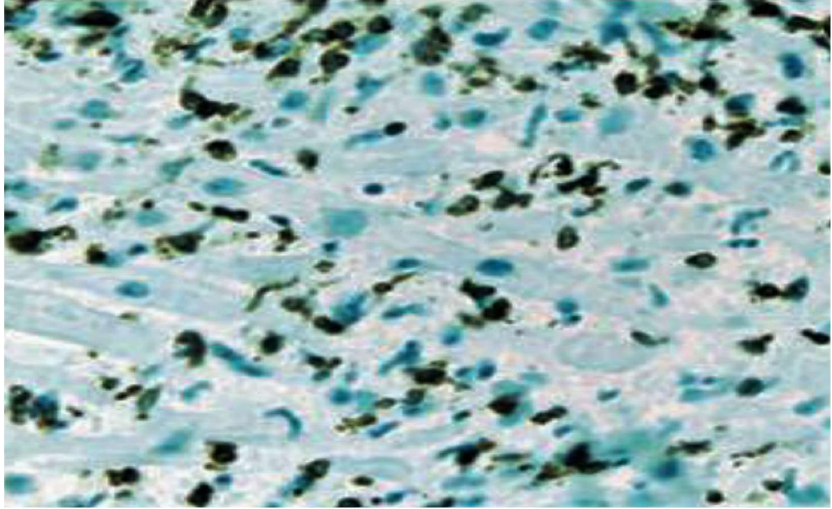
Figure 2. Borderline myocarditis characterized by the infiltration of lymphocytic and histiocytic cells is depicted using CD3 immunostaining of T